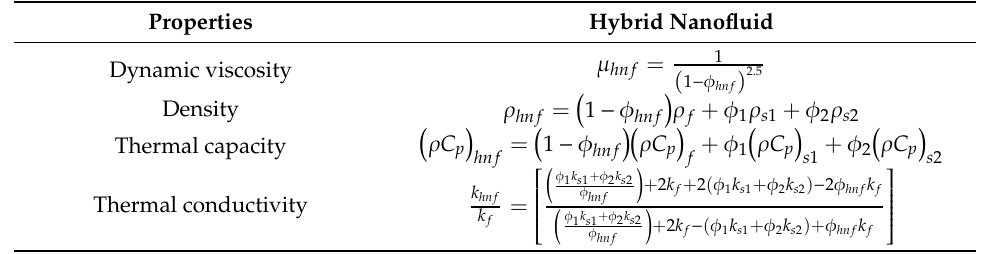
Table 2. Hybrid Al 2 O 3 -Cu / H 2 O nanofluids thermophysical properties (Takabi and Salehi [53], Ghalambaz et al.